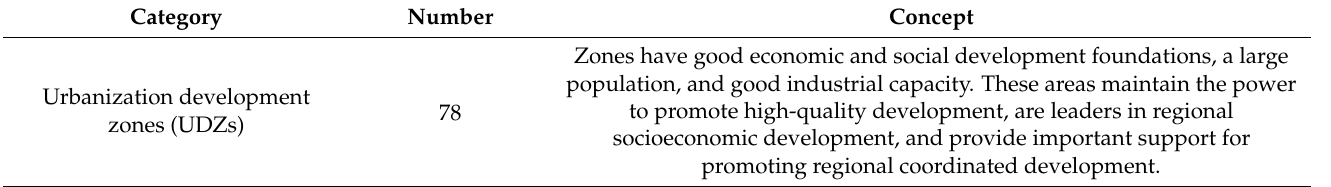
Table 1. Basic information on the major function-oriented zones (MFOZs) in Guangdong Province